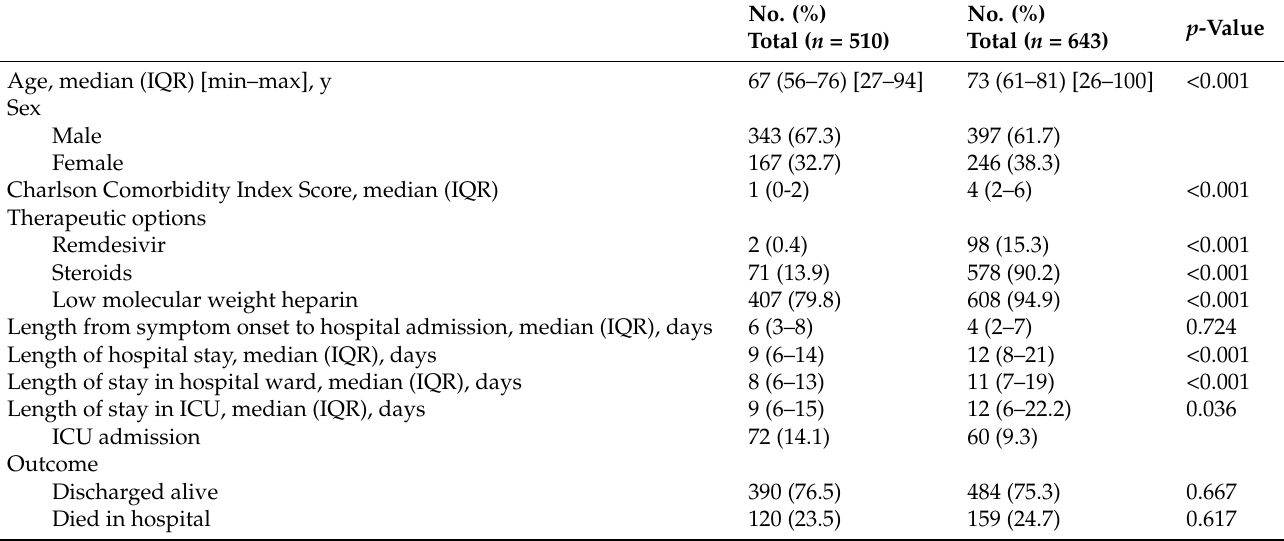
Table 1. Demographic and clinical characteristics of COVID-19 patients admitted to the IRCCS Humanitas Research Hospital. Dichotomous variables were analyzed with the Z-proportion test, while non-dichotomous variables were analyzed with Pearson’s χ 2 test. Regressive variables were analyzed with the Wilcoxon regression